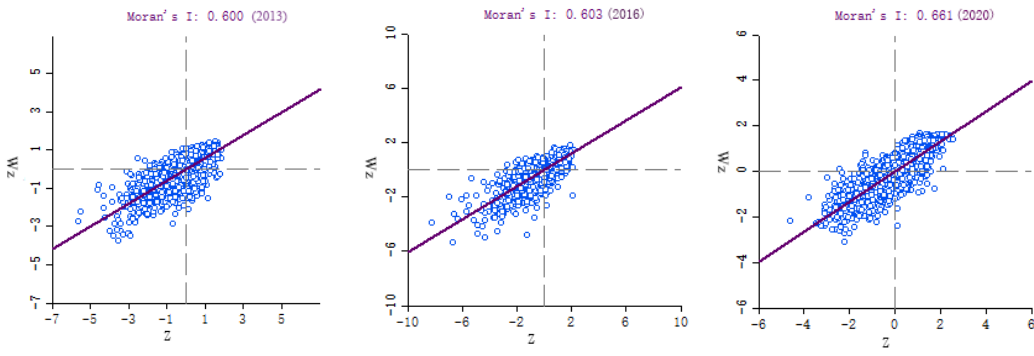
Figure 6. Moran’s I scatter plot.